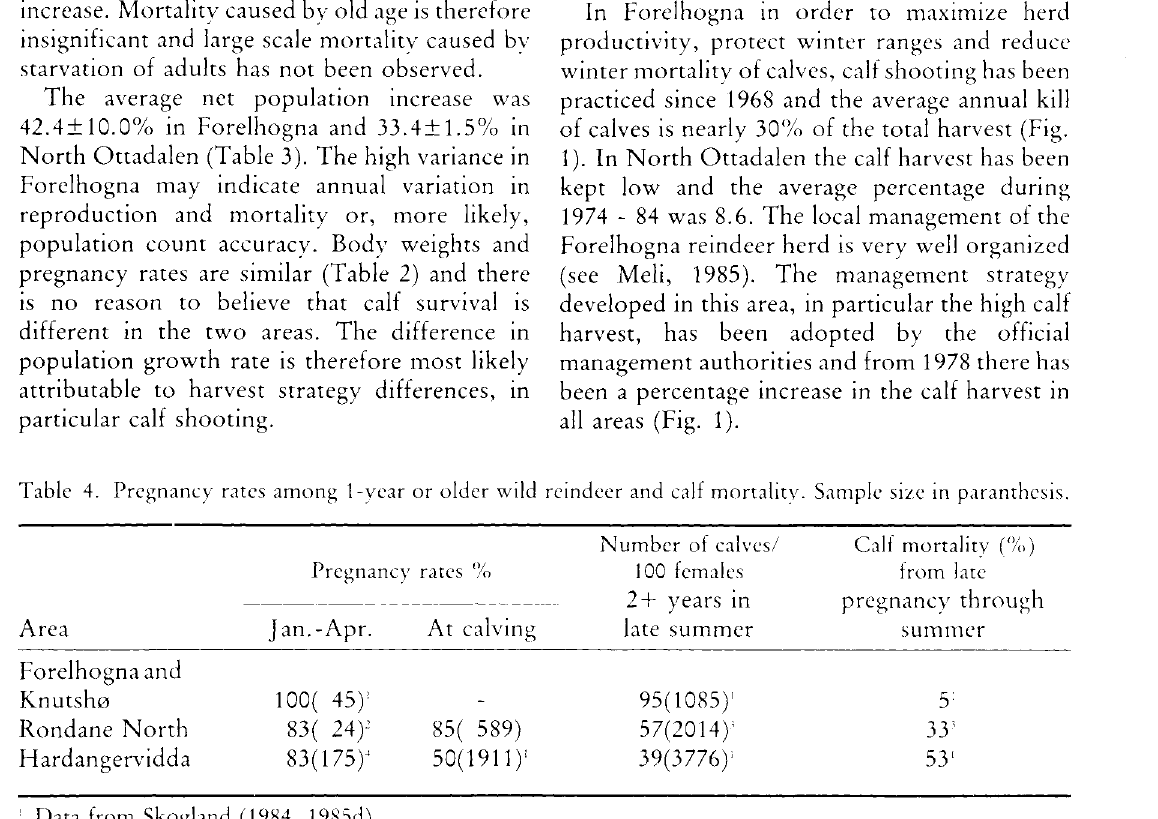
Fig. 2. The relationship between carcass weight (kg) or mandible length (cm) and harvest success.